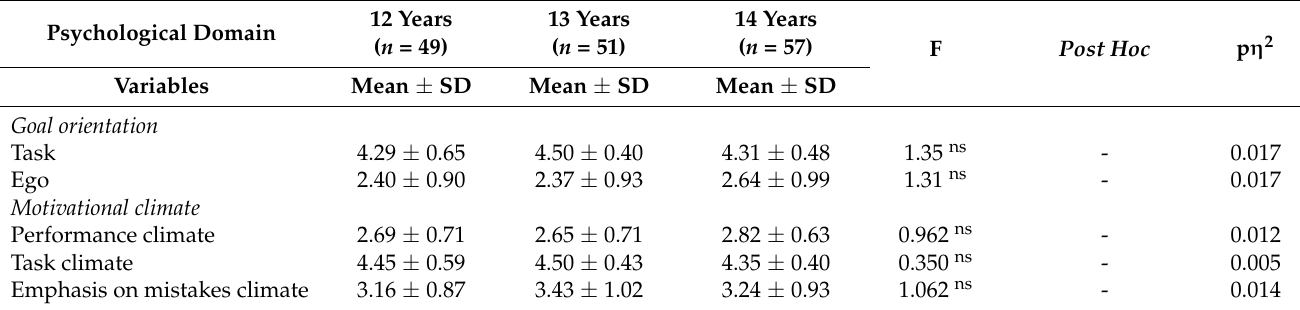
Table 5. Descriptive statistics [means and standard deviations (SD)], ANOVA results (F and post hoc tests), and partial eta square (p η 2 ) for the psychological